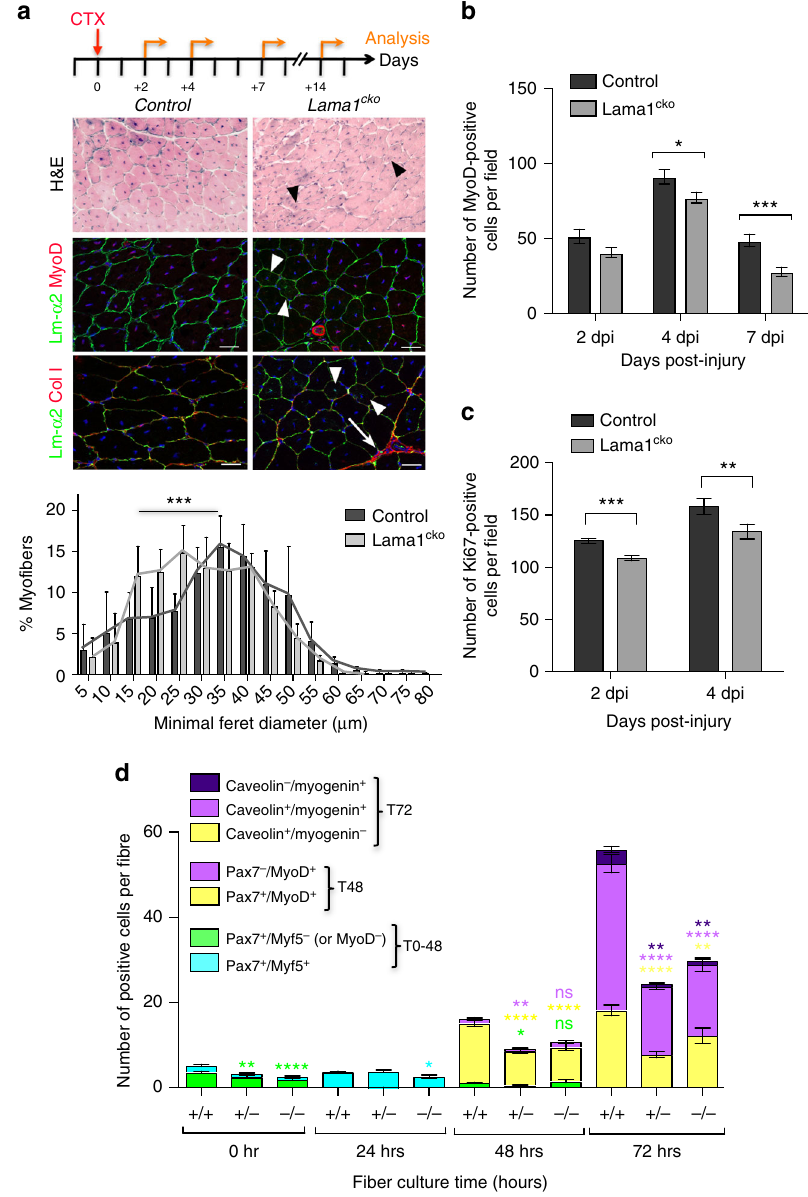
Fig. 4 Laminin- α 1 is essential for SC proliferation. a Control and Lama1 cko Tibialis anterior (TA) muscle analyzed at 14 days post injury by Haematoxylin and Eosin staining, and immuno fl uorescence for laminin- α 2 (green), MyoD (red), and collagen I (red). Black and white arrowheads indicate the presence of smaller regenerated myo fi bers in Lama1 cko mice. White arrows indicate sites of fi brosis. The graph shows the minimal Feret diameter analysis of control and Lama1 cko TA muscles at 14 dpi. Scale bar, 50 μ m. n = 3 per genotype. b Number of MyoD + cells in injured TA muscles at 2, 4, and 7 dpi in control and Lama1 cko mice. n = 3 per genotype. c Number of Ki67 + cells in injured TA muscles at 2 and 4 dpi in control and Lama1 cko mice. d Quanti fi cation of the number of satellite cells activated (blue), proliferating (yellow), self-renewing (green), and differentiating (purple) in a 72-hour ex-vivo culture of control, heterozygous, and Lama1 cko myo fi bers. n = 3 per genotype with 31 – 79 myo fi bers per time point. Graphs show mean + sem. * P < 0.05, ** P < 0.01, *** P < 0.001, **** P < 0.0001 ( t -test for b , c , and d , and one-way ANOVA for a